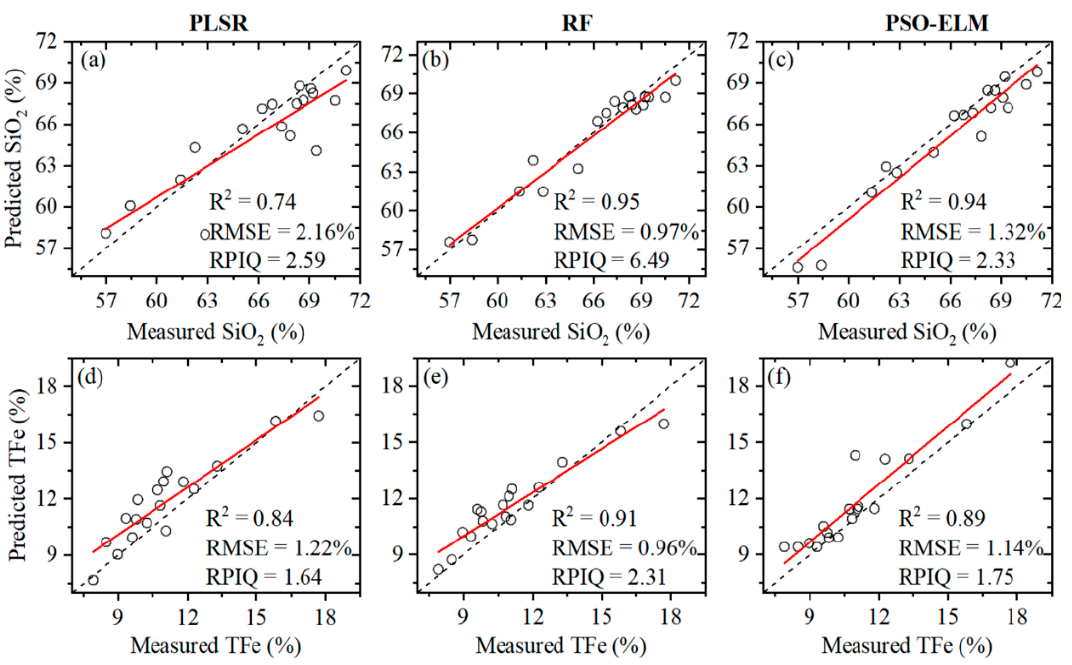
Figure 12. Validation between the measured and predicted value of SiO 2 ( a – c ) and TFe ( d – f ) in the |r| ≥ 0.80 band range from fusion spectra using the PLSR, RF, and PSO–ELM models. The dashed line shows the 1:1 relationship and the red line shows the model trend.